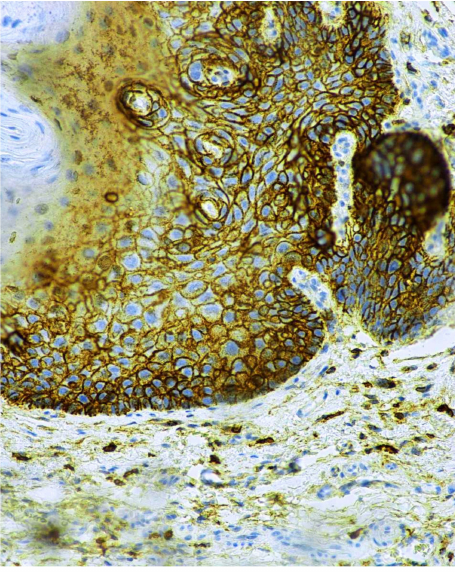
Figure 8. Membranous and intra-cytoplasmatic expression of the CD44 antigen in non-homogenous oral leukoplakia. Immunoperoxidase, anti-CD44, original magnification 200 × .